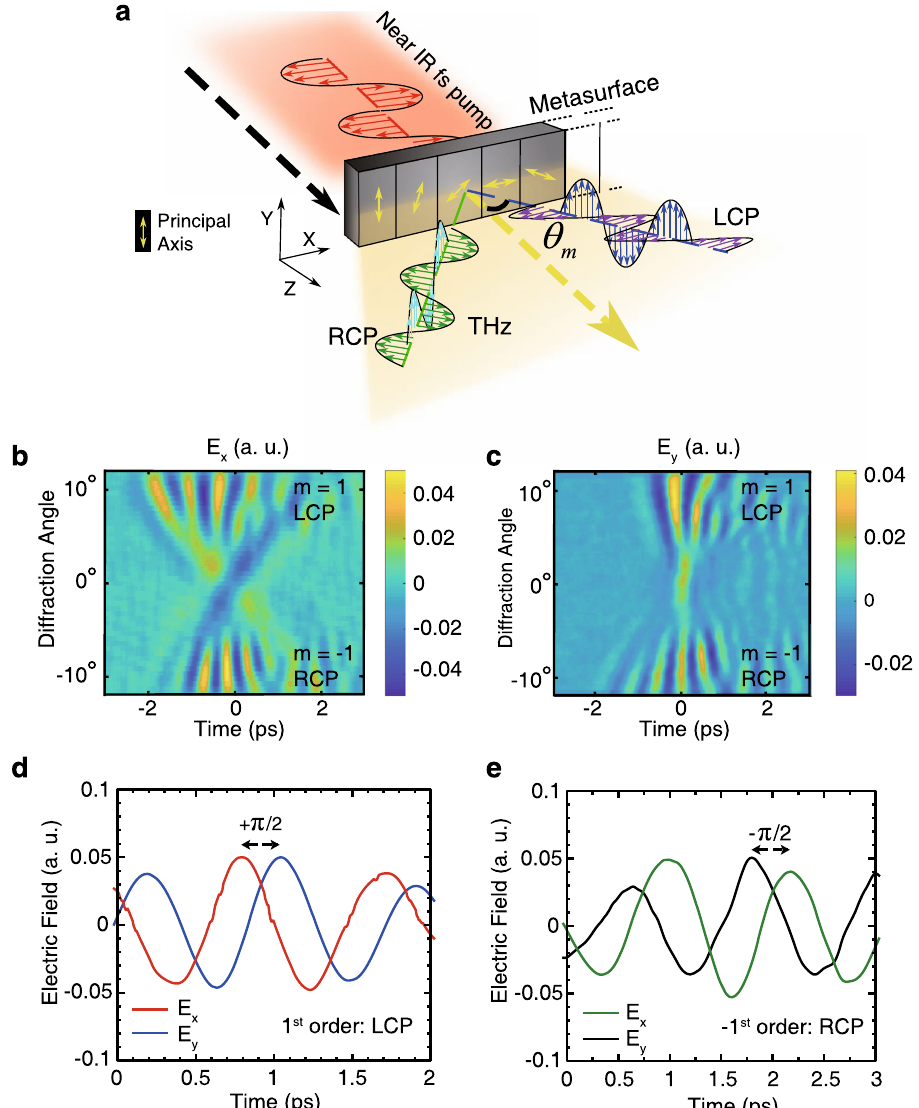
Fig. 2 Spin-orbit interaction for THz waves. a Schematic illustration of a 1 mm section of the metasurface for generation of spatially separated LCP and RCP THz waves. The arrows indicate the rotation direction of the meta-atoms ’ principal axis. The LCP and RCP states are diffracted to the m = 1 and m = − 1 states, respectively, at angles of θ E E fi elds after NIR pumping, showing multicycle pulses diffracted into x and c y components of the THz temporal m . b orders of m = − 1 (RCP) and 1 (LCP). In the frequency domain, this part of the waveform consists of frequency components from ~2.0 THz to 2.5 THz for both E x and E y fi elds, where lower frequencies diffract to angles beyond the numerical aperture of the collection system. d Relative phase shift of the E x and E fi elds in the m = 1 and e m = − 1 diffraction orders for the determination of circular polarization handedness. In the case of the m = 1 diffraction order, a y positive phase shift is observed from E x to E y indicating LCP light. For the m = − 1 diffraction order, the opposite is observed, indicating RCP